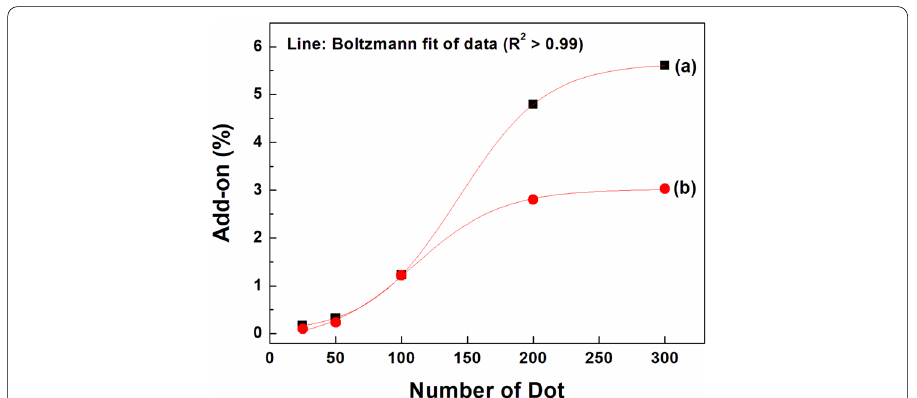
Fig. 3 Add-on (%) of gallotannin-printed cotton fabrics: a after gallotannin printing and drying, b after completing the whole printing process including printing, drying, curing, washing, and